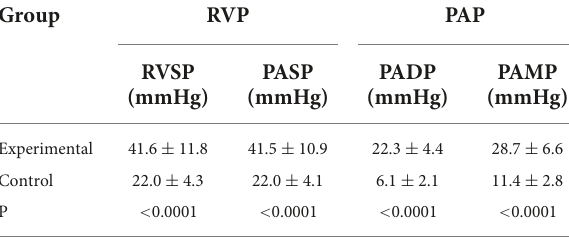
TABLE 2 Comparison of pressure measurements between MCT group and control